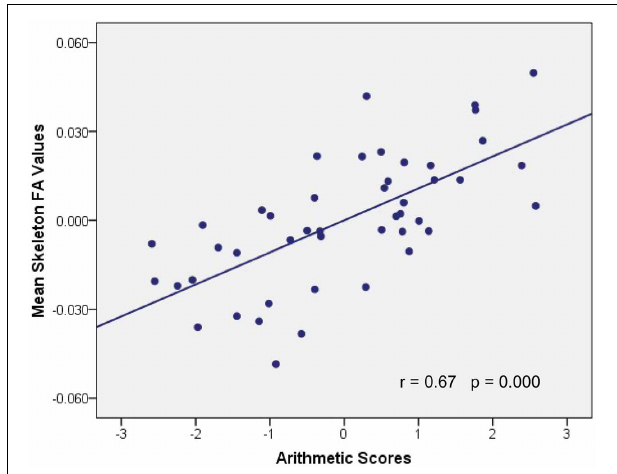
FIGURE 4 | Association between mean FA values and WISC-RC arithmetic scores. Parietal residual plot with trend lines depicting the correlation between residuals in multiple regression analysis investigating the association between the mean FA values in the WM clusters and the WISC-RC arithmetic scores for entire cohort, after correction of full-scale IQ, age, and gender. r denotes the partial correlation coefficient.